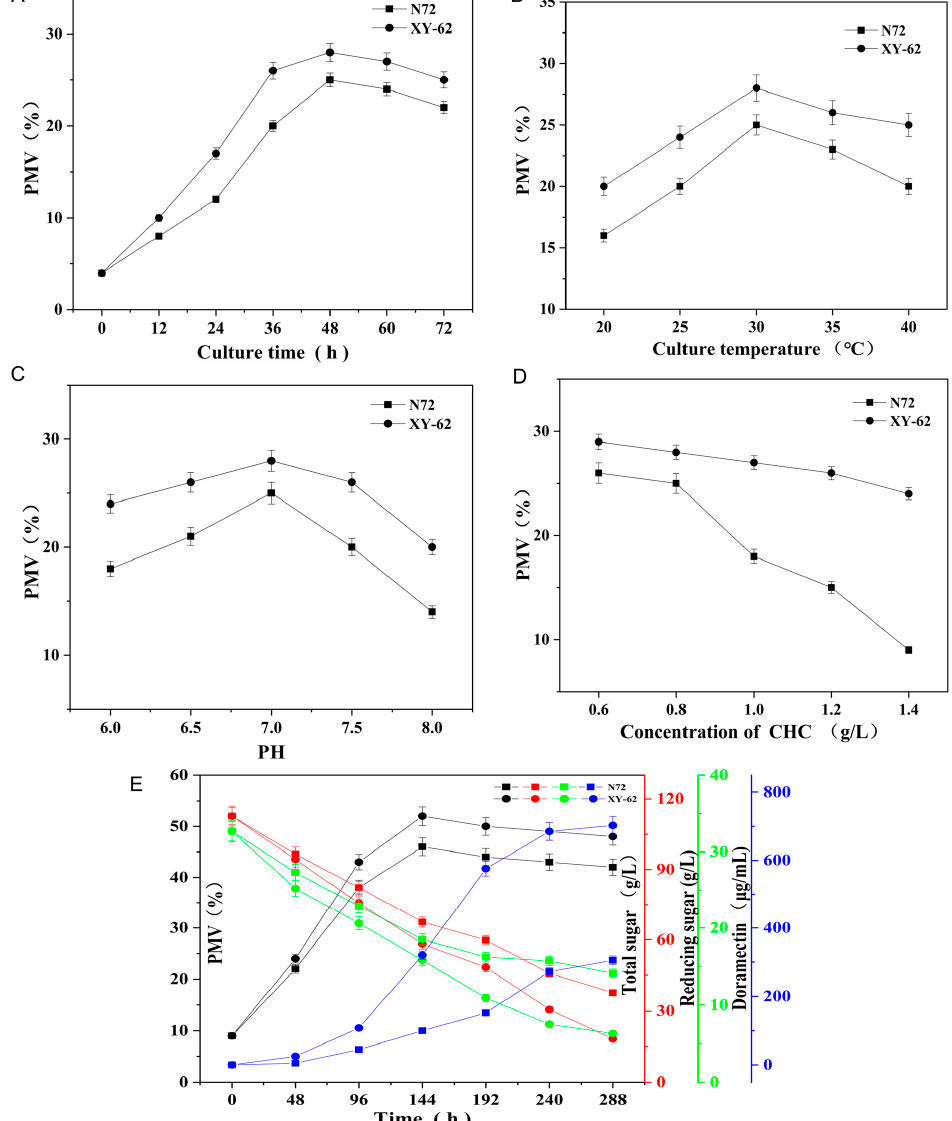
Figure 4 . Differences in growth and metabolism between S. avermitilis N72 and XY-62 shake flasks. ( A ) effect of different incubation times on biomass, ( B ) effect of different incubation temperatures on biomass, ( C ) effect of different pH values on biomass, ( D ) effect of different CHC concentrations on biomass, ( E ) fermentation shake flask growth and metabolism curves.